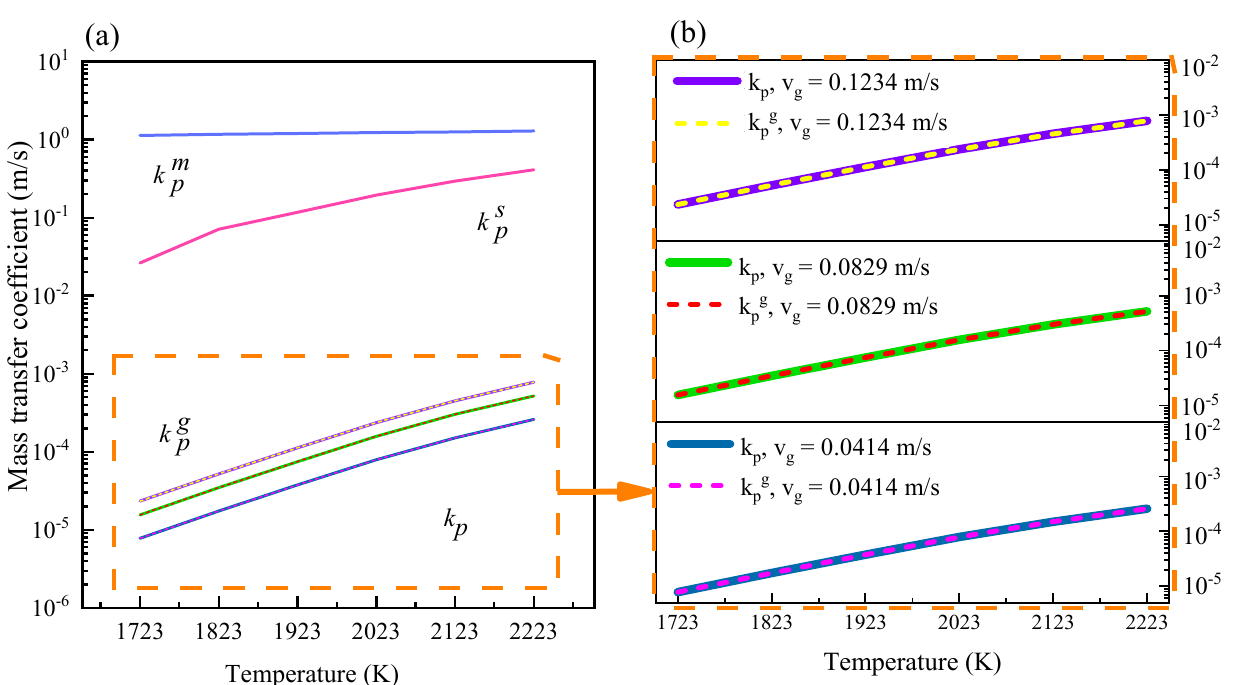
Figure 5. ( a ) Mass transfer coefficients of phosphorus in 600 MPa steel; ( b ) enlarged diagram of the mass transfer coefficients in the gas phase and for the whole process.